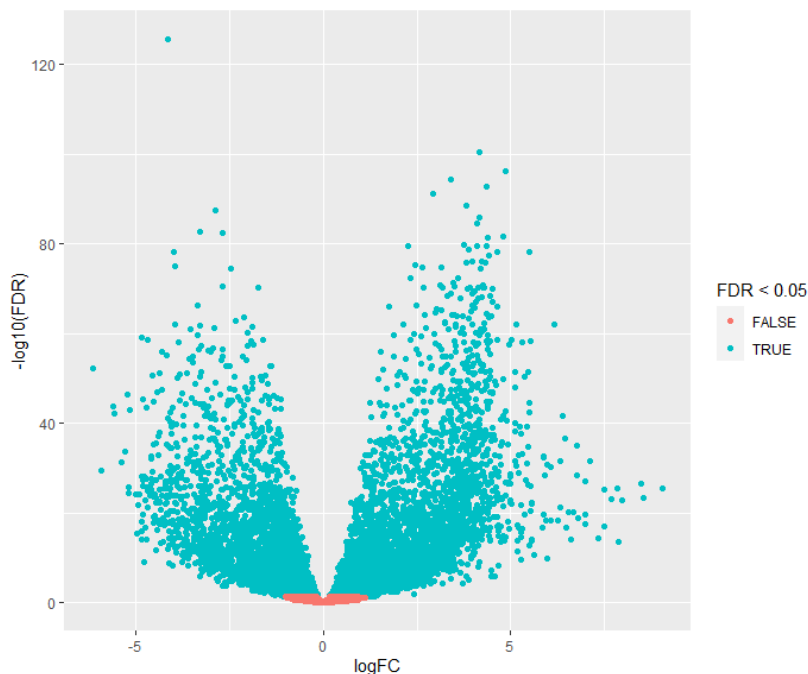
Figure A5. Volcano plot of the genes ( n = 13,824) after filtered for low expression in PDAC stroma ( n = 123) and epithelium ( n = 66) samples. Sixty-six out of 123 stroma samples are matching counter- parts of epithelium samples. Cyan and orange dots indicate genes that are differentially expressed ( n = 8944) and no change in expression between the epithelium and stroma ( n = 4880), respectively (FDR < 0.05).